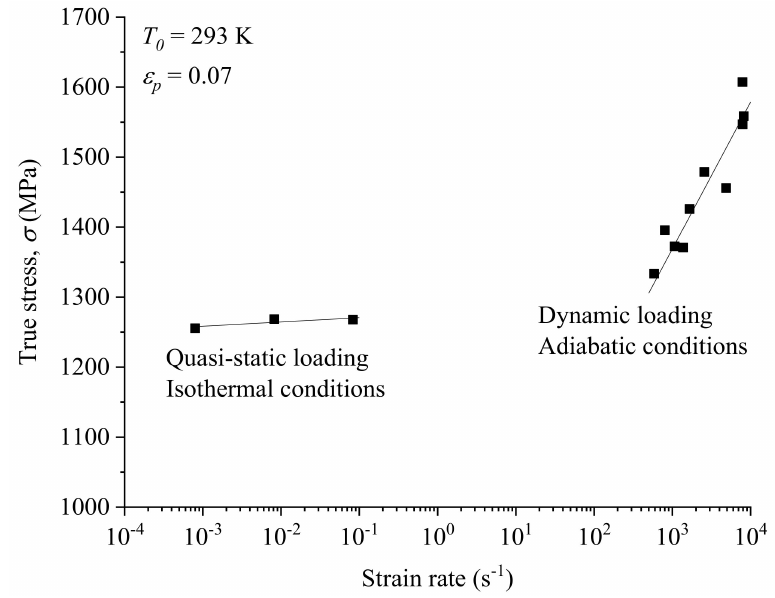
Figure 5. True stress vs. strain rate for a strain level of ε p = 0.07 ε p = 0.07 at room temperature during compression tests.